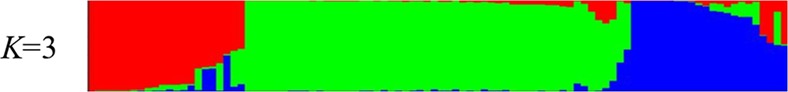
Grouping of 98 almond accessions genotyped at 40 SSR loci based on STRUCTURE analysis.Green and blue represent individuals within the subpopulations. Any blue or green bar that is not completely filled indicates admixture.